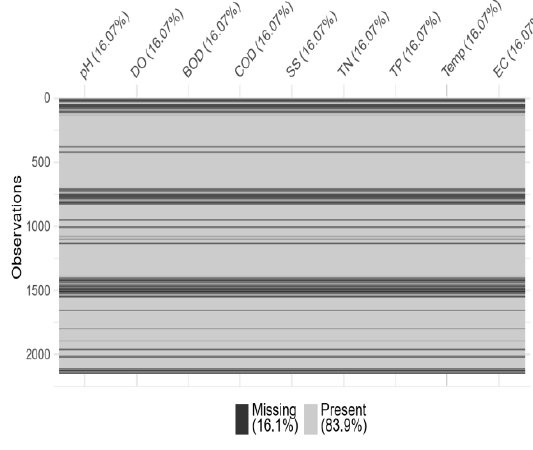
Figure 2. Map of missing data.